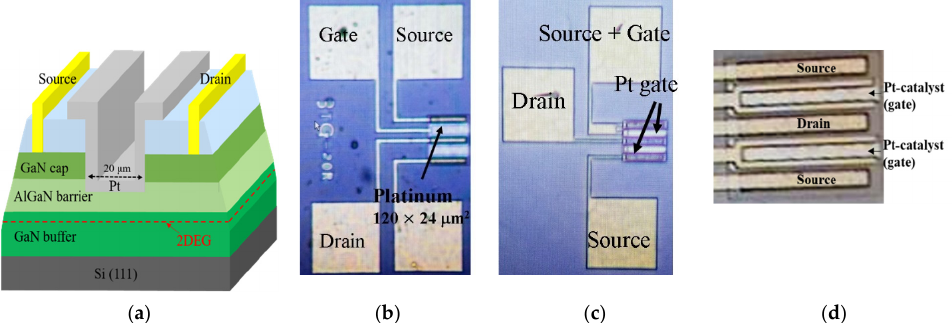
Figure 1. ( a ) The schematic cross-sectional 3D diagram of the recessed AlGaN/GaN HEMT-based sensors on a Si substrate. In standard (no-recess) sensors, the layers under the gate region are in situ SiN x , GaN cap, and AlGaN, respectively. W G /L G = 120 μ m/24 μ m. ( b ) Microscopic image of a 3-terminal standard HEMT sensor (upper) and a floating gate sensor (lower). ( c ) Microscopic image of a 2-terminal SCG sensor (upper). ( d ) Magnified image of active area showing Pt-catalyst.